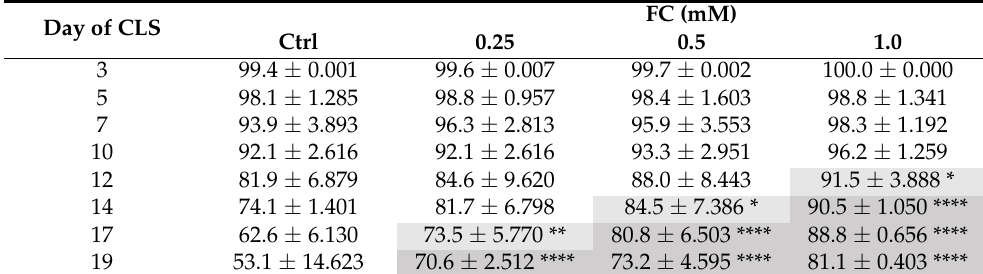
Table 2. Effect of FC supplementation on yeast CLS. Mean percentage of live cells on the following days of CLS assay. Data are presented as mean ± SD from three independent experiments. Statistical significance versus control (ANOVA): (*) p < 0.05, (**) p < 0.01, (****) p < 0.0001. Day of CLS